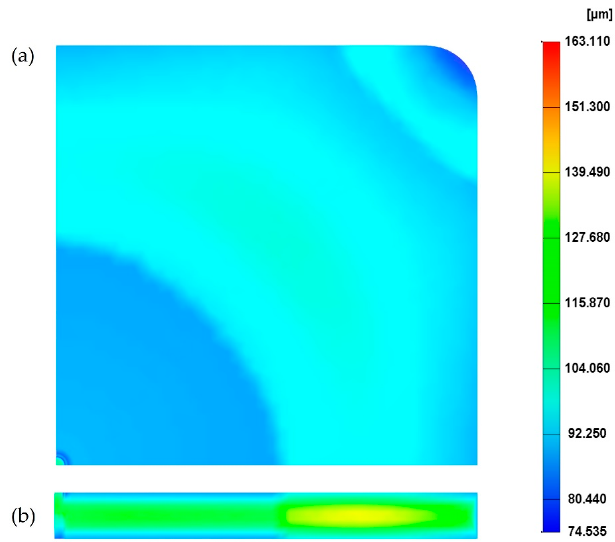
Figure 23. The cell distribution at the surface ( a ) and cross-section ( b ) of the MuCell ® part considering a shot volume of 95%.